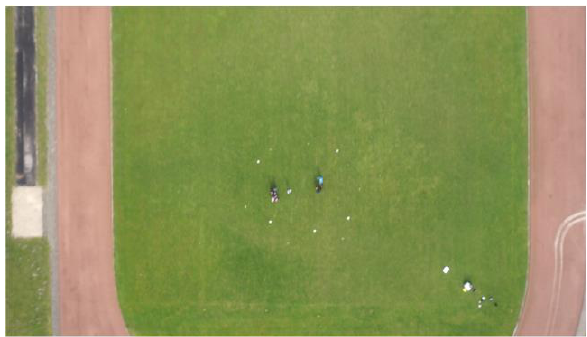
Figure 5. RGB imagery at an altitude of 70